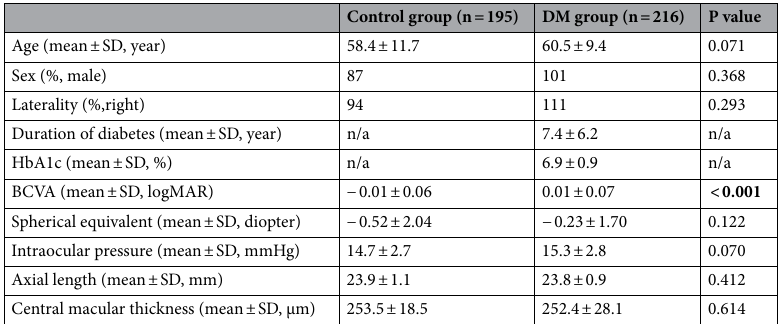
Table 1. Demographics and clinical characteristics. Significant values are in bold. BCVA best-corrected visual